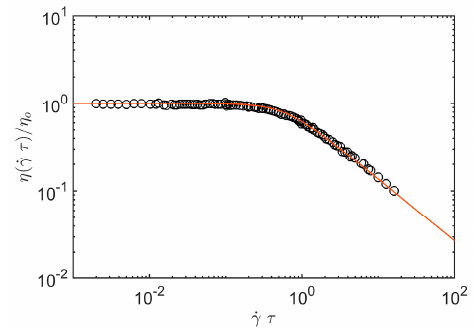
. Figure 1. Shear viscosity η ( γτ ) of concentrated “entangled” polystyrene solutions under steady-shear Figure 1. Shear viscosity η (  (cid:4662) τ ) of concentrated “entangled” polystyrene solutions under steady-shear . γτ . Solid line denotes Equation (10) of the present paper conditions as a function of reduced shear rate, conditions as a function of reduced shear rate,  (cid:4662) τ . Solid line denotes Equation (10) of the present where the data is taken from Graessely paper where the data is taken from Graessely [54].